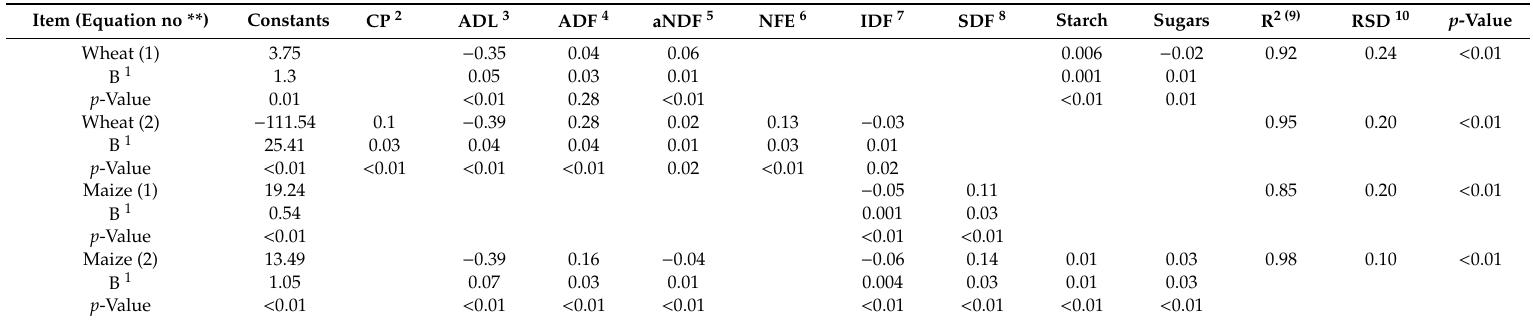
Table 6. Chosen regression equations for prediction of AME N (kcal · kg − 1 ) of wheat and maize grain from crude nutrient content